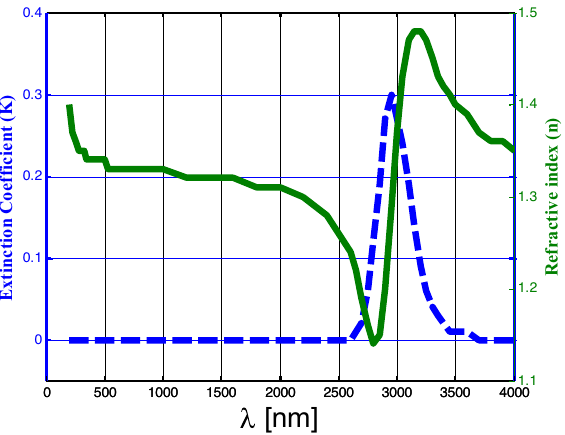
Figure 5. Refractive index and extinction coefficient of water as a function of incident wavelength as